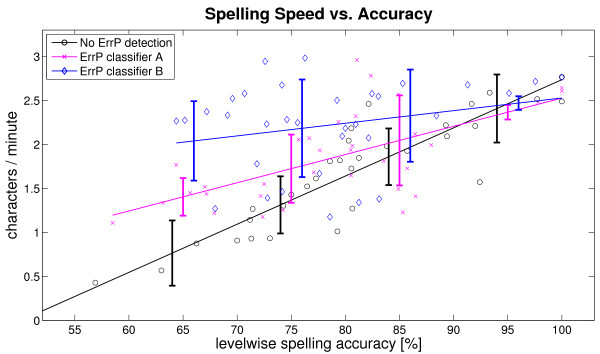
Speed vs. Accuracy. Scatter plot of the spelling speed in dependence of the levelwise spelling accuracy. Each data point refers to one experimental block of one participant (nine data points per participant). The blocks in which the ErrP detection was turned off are depicted as black circles, the blocks in which classifier A was used to detect ErrPs are depicted as magenta crosses and the blocks of classifier B are depicted as blue diamonds. For each condition a line was fitted to the data using least squares. The error bars depict the standard deviation of the accuracy in the bands 100-90%, 90-80%, 80-70% and 70-60%.